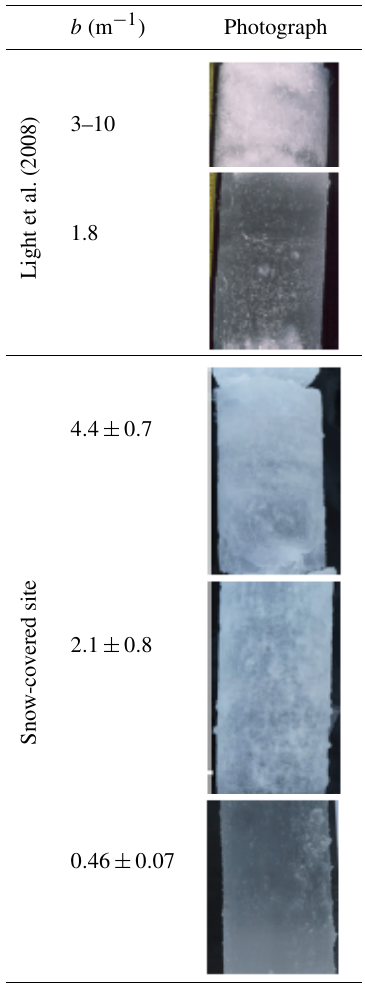
Table 2. Average b measurements together with ice core pictures for the three zones we identified at the snow-covered site compared to the b measurements and pictures of drained ice and interior ice adapted from Light et al.